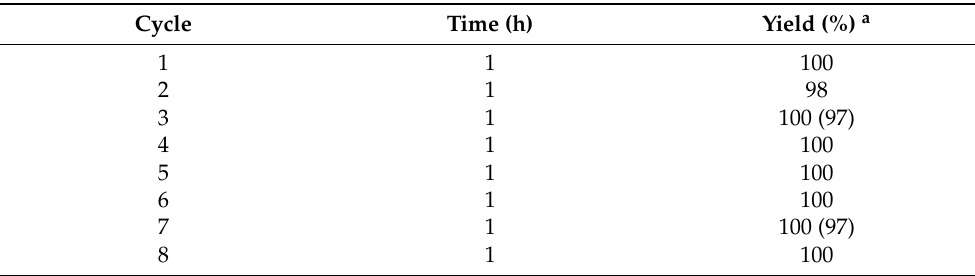
Table 2. Hydrosilylation reactions of 5-decyne ( 4 ) and dimethyl-phenylsilane ( 3′ ) under thermomorphic condition.